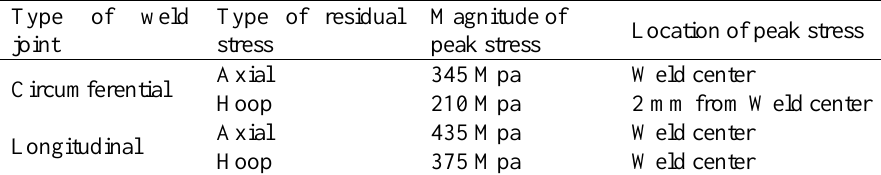
Table 5. The magnitude of residual